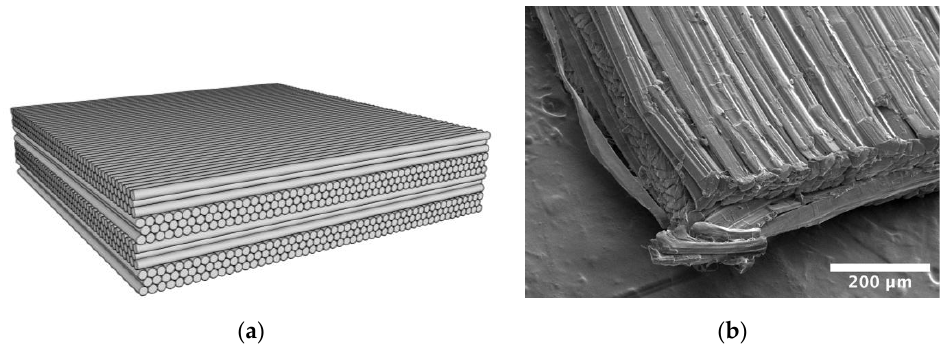
Figure 1. Schematic representation ( a ) of the UD laminate showing the hexagonal packing and the four perpendicular UD layers, each three fibers thick, and a micrograph ( b ) showing the structure of the actual material.